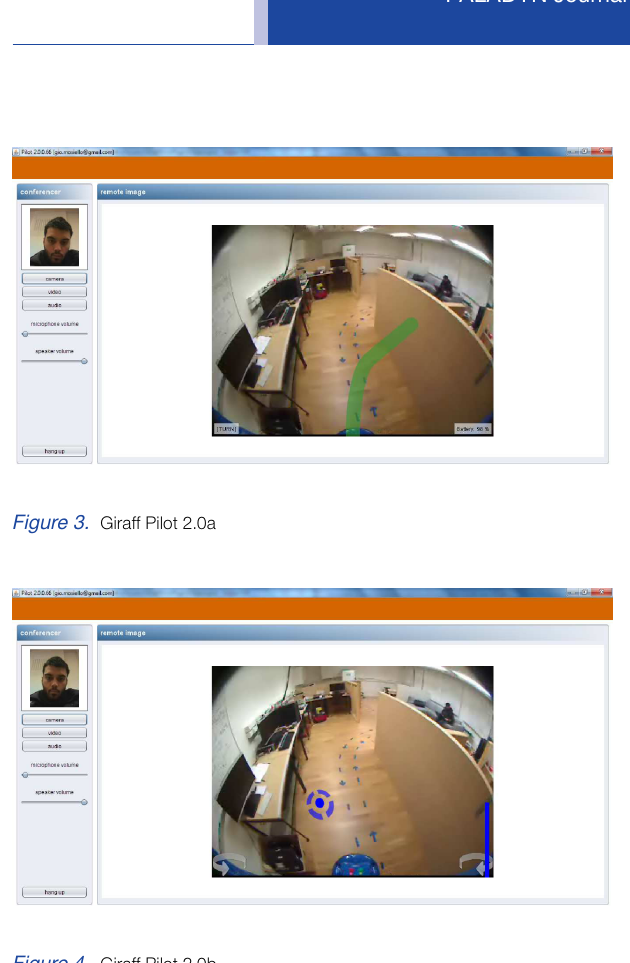
Figure 4. Giraff Pilot 2.0b